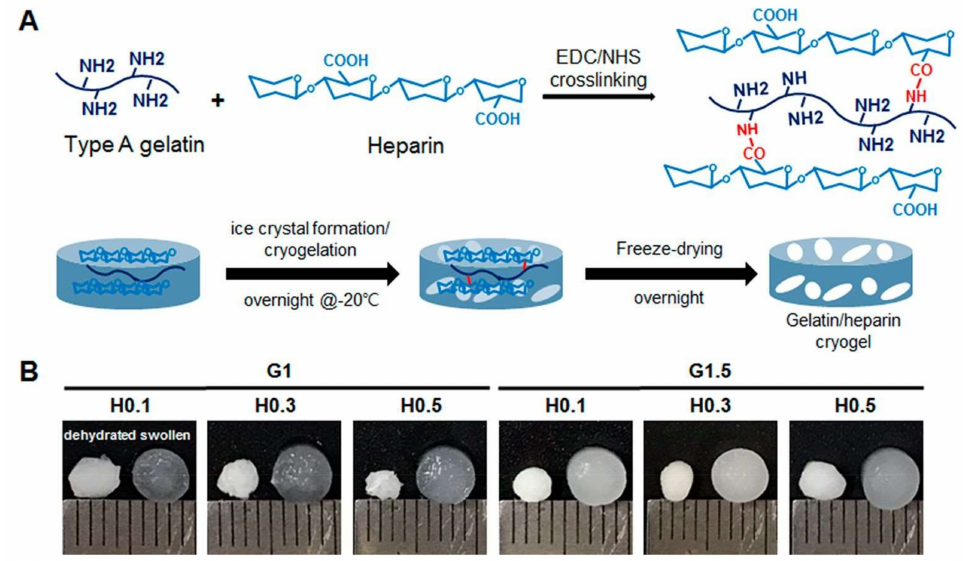
Figure 13. Preparation of composite cryogel ( A ) and mechanical properties in di ff erent gelatin concentration ( B ). Republished with permission from [73]. Copyright 2018